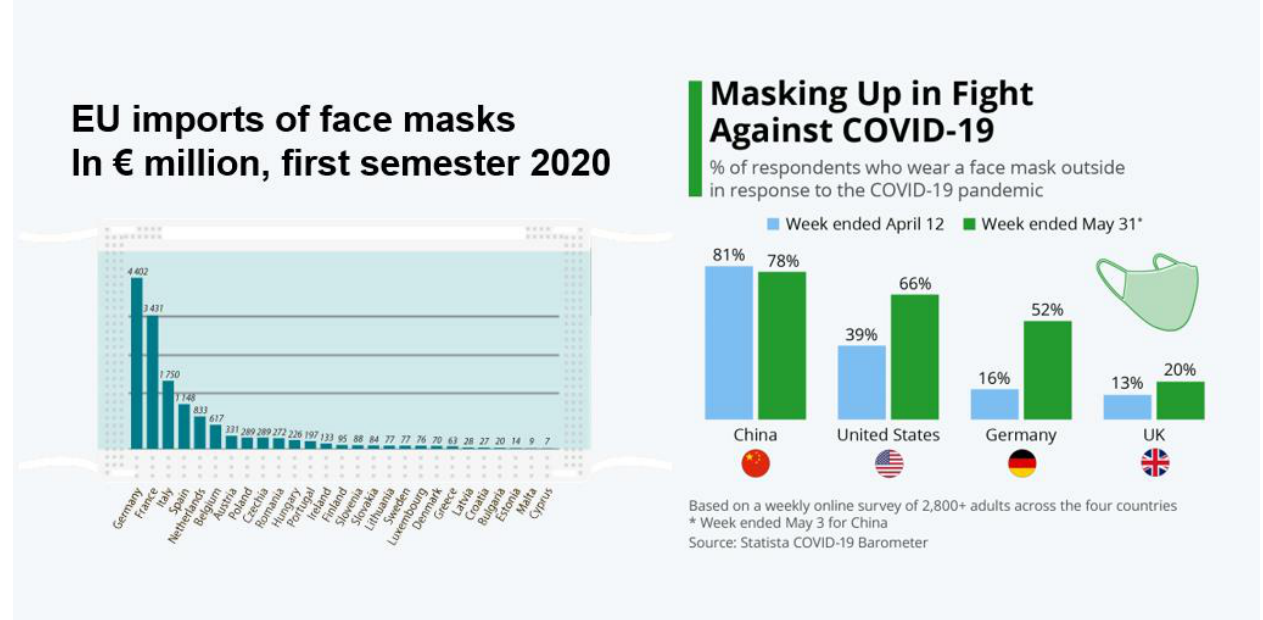
Figure 1. Differences among EU member states about face-mask importation costs (in EUR million) and % of people, by country, that use face masks to prevent COVID transmission. Source: EUROSTASTS and COVID-19 Barometer 2020.